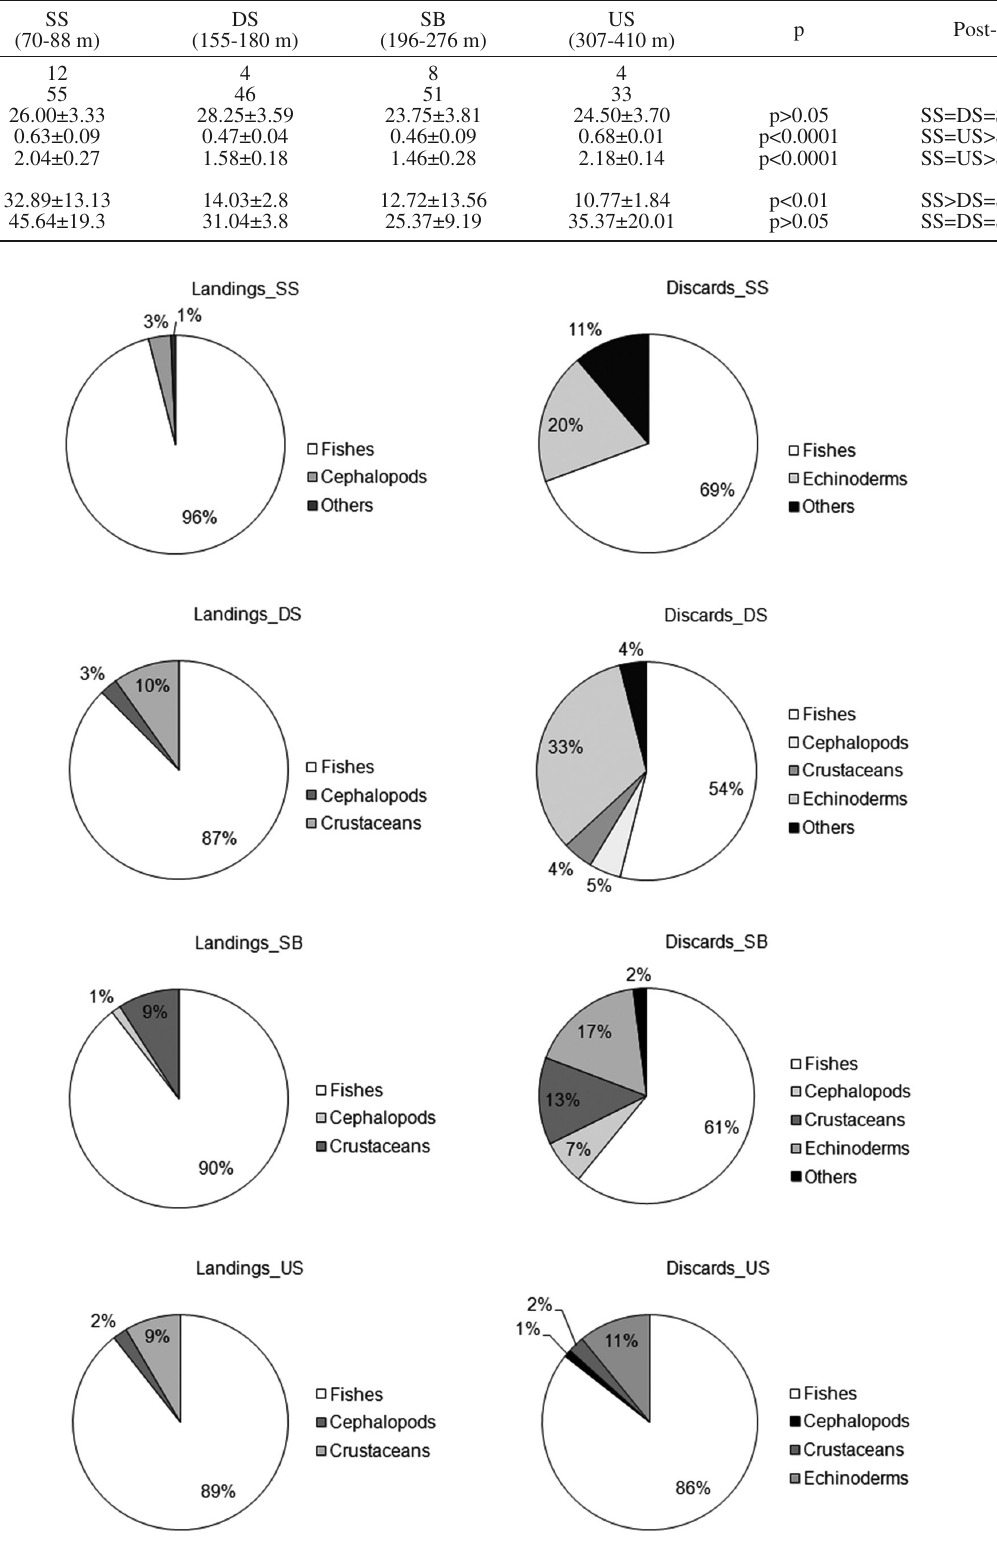
Fig. 3. – Biomass composition for landed and discarded groups of trawl samples obtained from cluster analyses. SS, shallow shelf; DS, deep shelf; SB, shelf break; US, upper